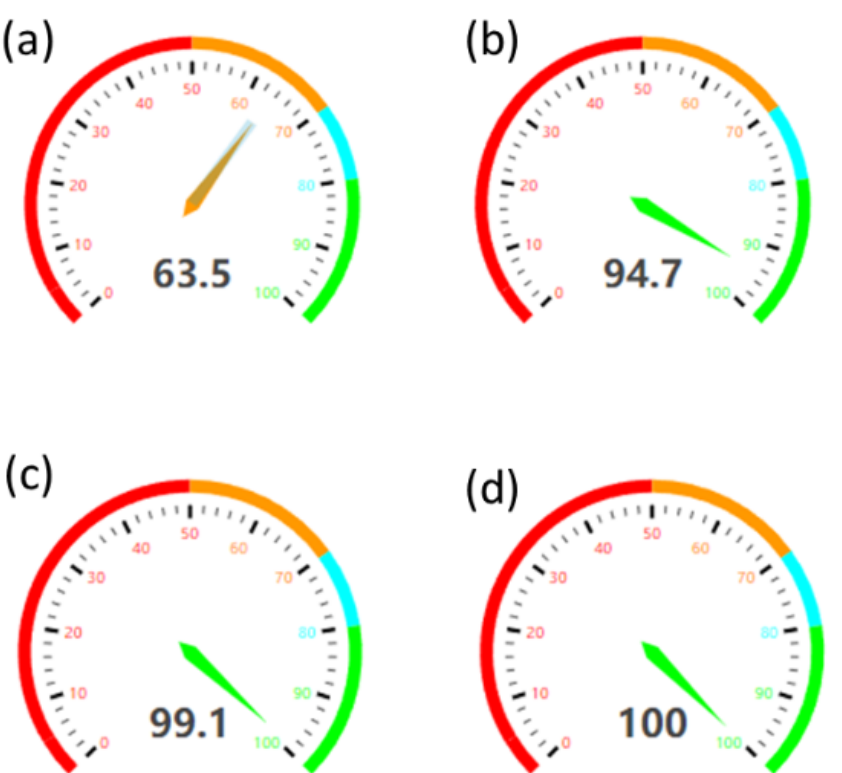
Figure 2. Testing procedures accuracy. ( a ) Antigen test (AT), ( b ) RT-PCR, ( c ) nanomaterial embod- iment testing, and ( d ) amplification and multiplexing of genome with nanomaterial FET embodi- ment testing.